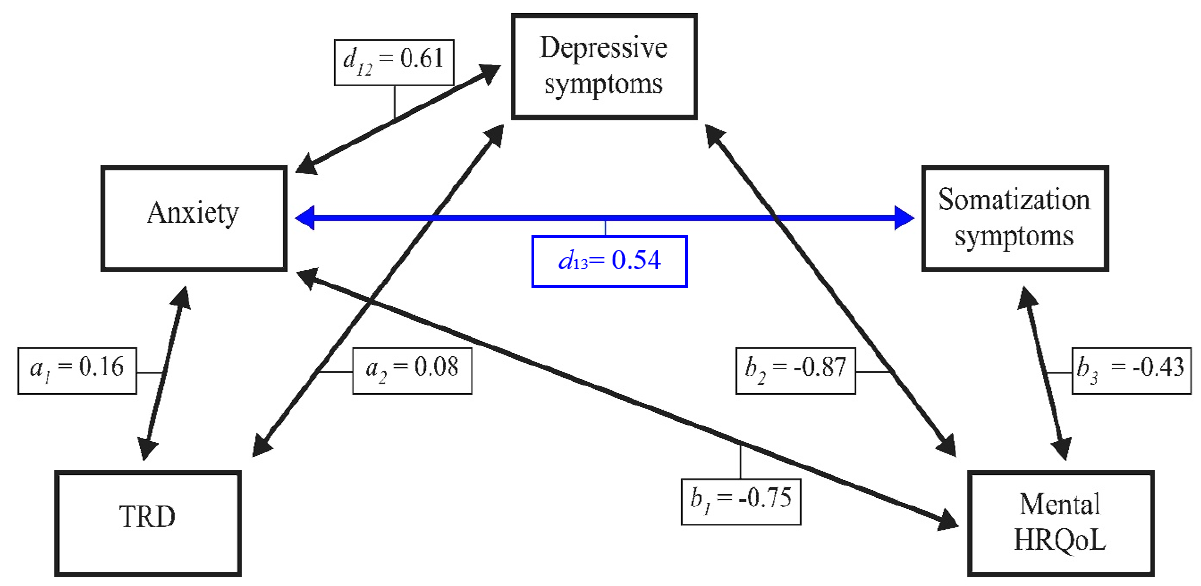
Figure 3. Anxiety, depressive symptoms, and somatization symptoms completely mediate the effect of TRD on mental HRQoL in male patients with chronic tinnitus. TRD = tinnitus-related distress; HRQoL = health-related quality of life. Numbers indicate unstandardized multiple regression coefficients. Blue lines indicate effects that are significant in male patients only.